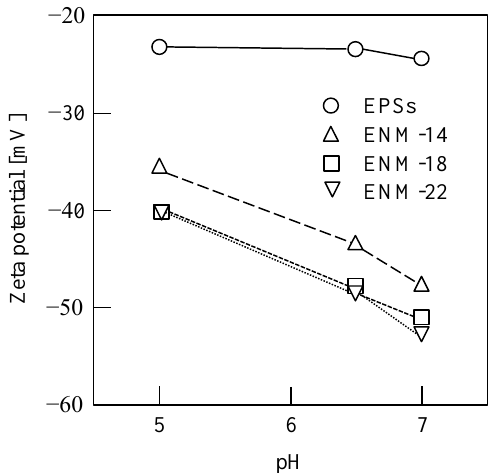
Figure 7. Typical photographic images of the ENMs with recycled and concentrated EPS ( a ) before and ( b ) after ultrasonic cleaning.